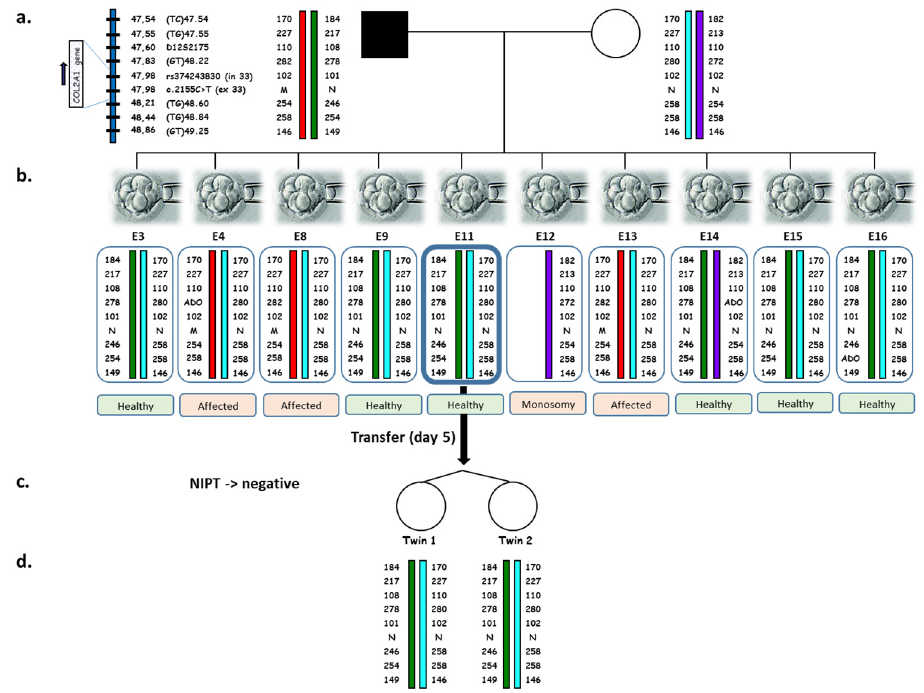
Figure 2. Pedigree and haplotypes at the COL2A1 locus obtained for the couple, PGT embryos, and twins. ( a ) Alleles from top to bottom correspond to the 7 extragenic informative STRs and the intragenic SNP, encompassing the COL2A1 c.2155C > T site, from centromere to telomere. Genomic locations (GRCh38/hg38) are indicated on the left of each marker. Allele length (in base pairs) is indicated for each marker for the couple, PGT embryos, and twin girls. M: mutant allele (c.2155T); N: normal allele (c.2155C). ( b ) PGT results obtained on one single blastomere from the 10 biopsied embryos on Day 3. ADO, Allele Drop Out. Embryo 11 was transferred on Day 5. ( c ) Noninvasive prenatal testing was performed at 12+3 WG. The results did not reveal the presence of the paternal COL2A1 variant. ( d ) Postnatal genetic testing of the twins at the COL2A1 locus showing identical results compared to the transferred embryo.